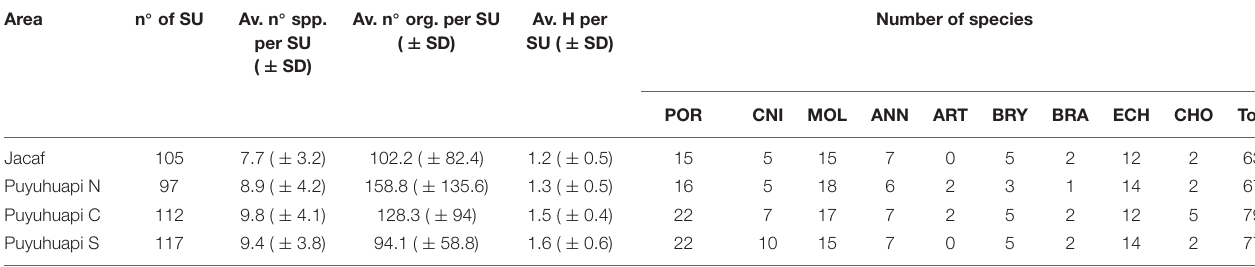
TABLE 1 | Overall differences in species composition and diversity of the invertebrate megafauna between the four study macro-areas. Area n ◦ of SU Av. n ◦ spp.